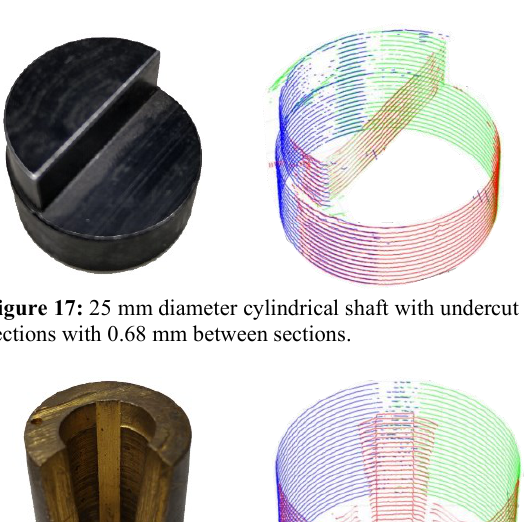
Figure 16: 28 mm rusty cube with groove – 25 sections with 0.68 mm between sections.